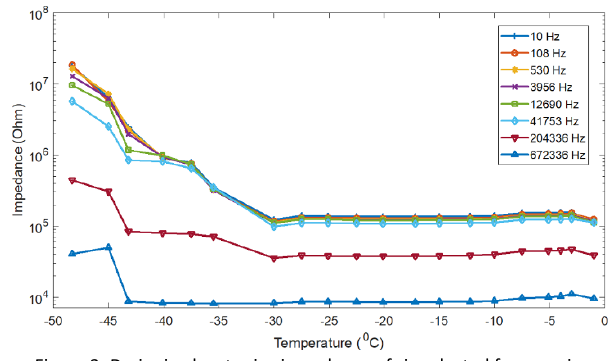
Figure 3: De-ionized water ice impedance of six selected frequencies as a function of temperature measured during heating (thawing).